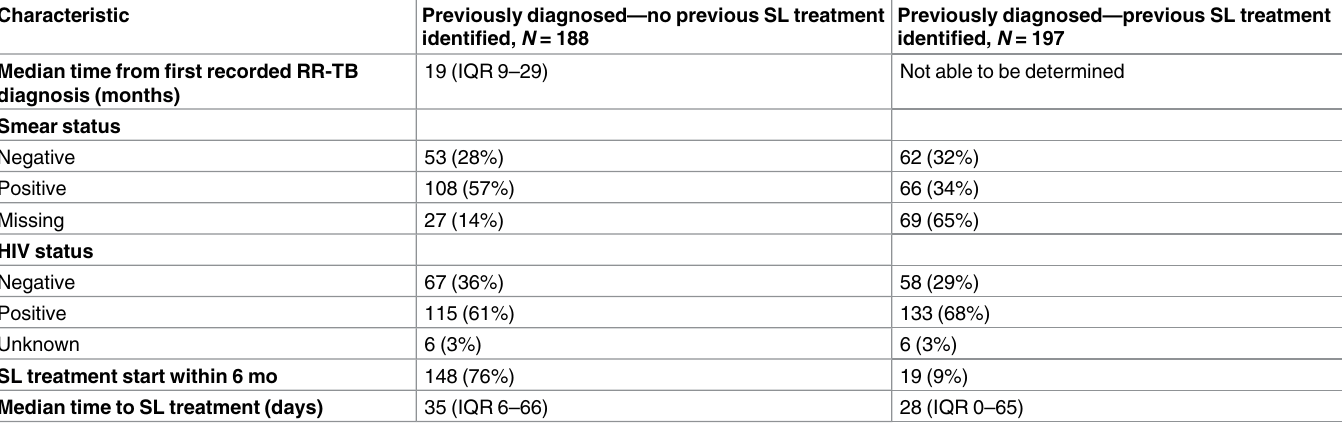
Table 4. For previously diagnosed rifampicin-resistant tuberculosis patients, time from first recorded rifampicin-resistant tuberculosis diagnosis, HIV status, treatment initiation, and time to treatment by previous second-line treatment status (not weighted for sampling method). Characteristic Previously diagnosed—no previous SL treatment Previously diagnosed—previous SL treatment identified, N = 188 identified, N = 197 Median time from first recorded RR-TB diagnosis